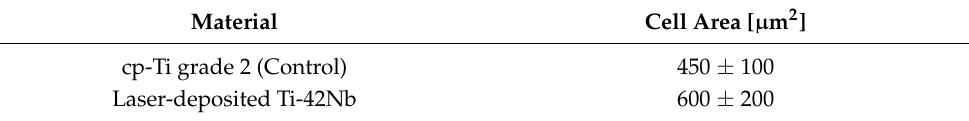
Table 3. Measured cell